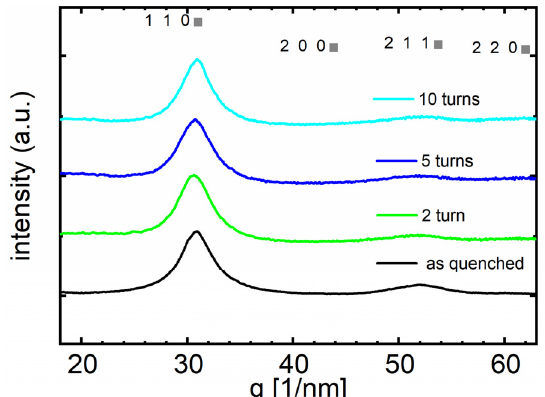
Figure 3. X-ray diffraction patterns of alloy A (Fe 73.9 Cu 1 Nb 3 Si 15.5 B 6.6 ) before (as-quenched) and after HPT-deformation at N = 2, 5, and 10. The positions of the expected crystalline peaks for α -Fe are indicated to highlight that the sample remains amorphous.